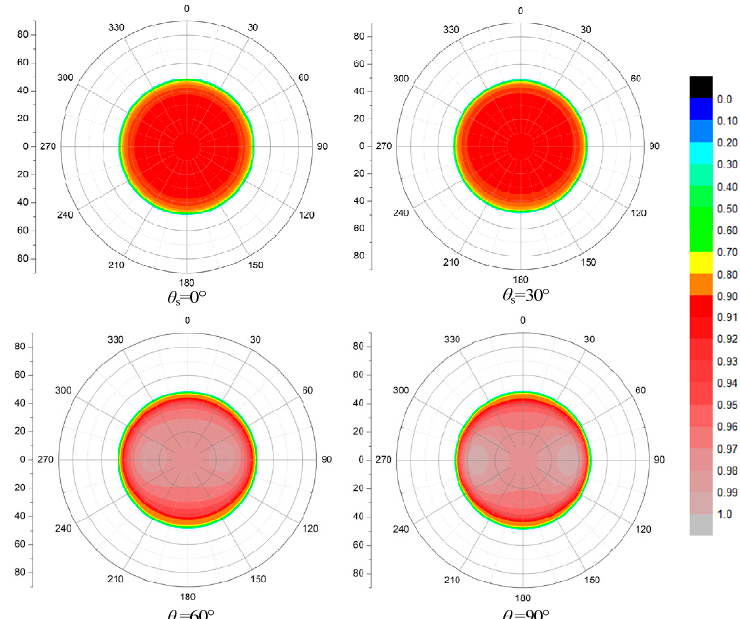
Figure 6. The intensity distributions of skylight transmitted through a calm water surface within the Snell’s window at different solar zenith angle θ s = 0°, 30°, 60°, 90°, the intensity range from 0 to 1.